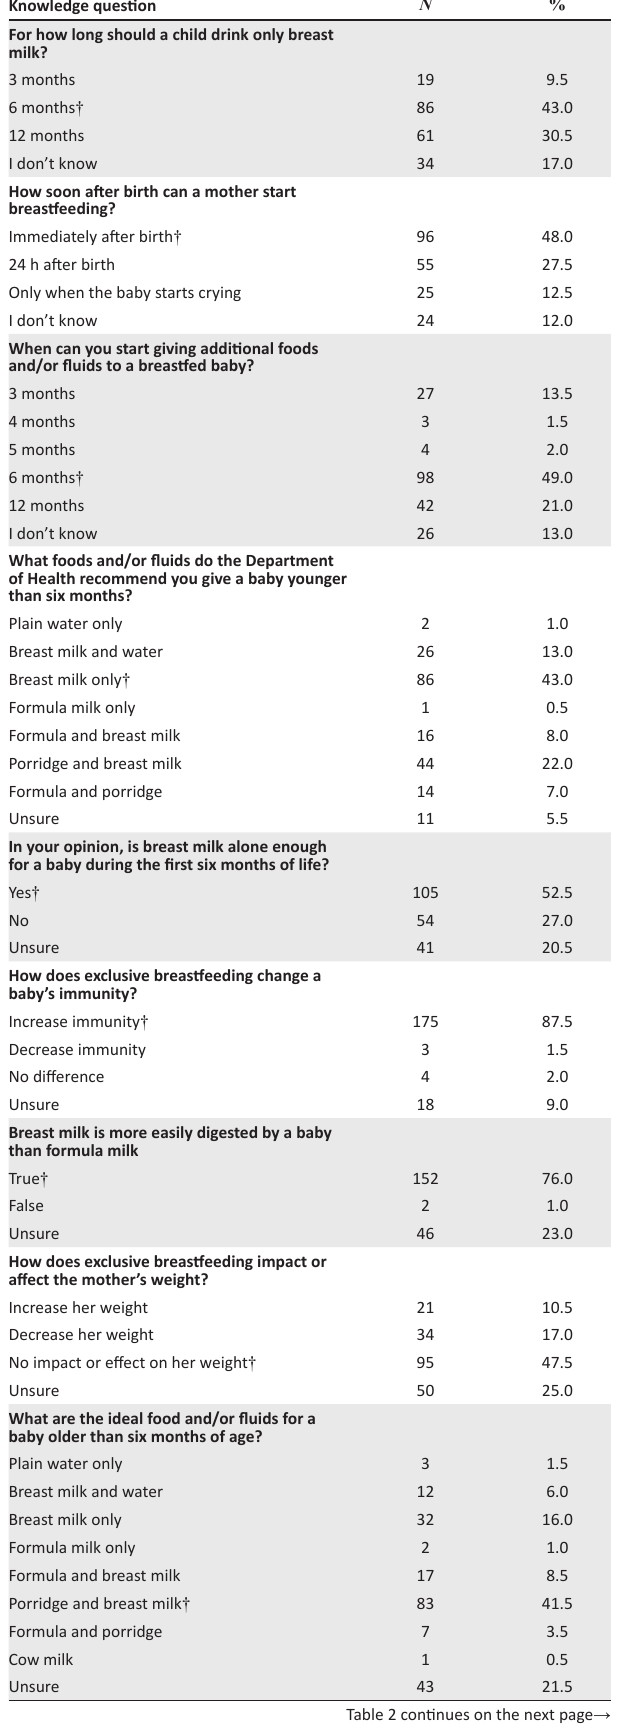
TABLE 2: Responses to exclusive breastfeeding knowledge